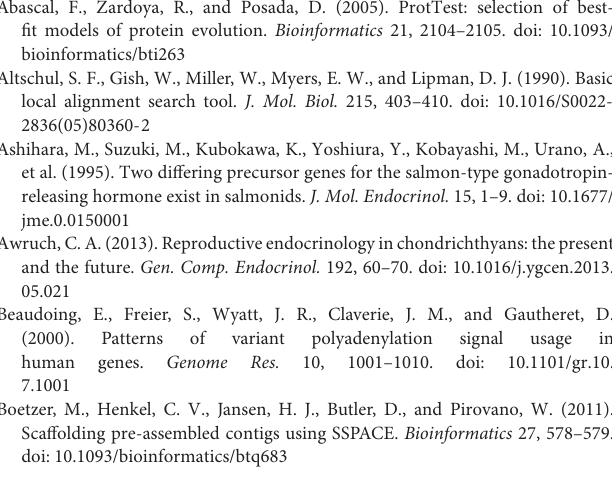
sequences. Legends are the same as in the Figure 1 . are the same as in the Supplementary Data Sheet S4